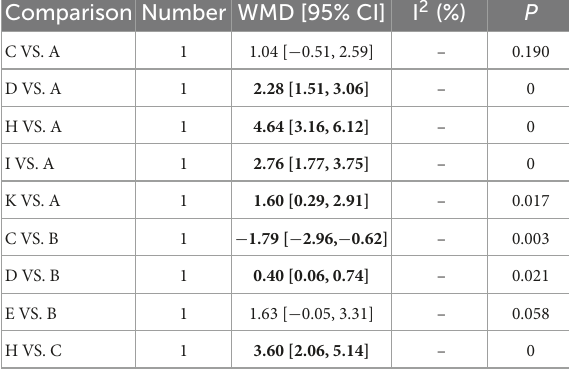
TABLE 4 Pittsburgh Sleep Quality Index (PSQI) pairwise meta-analysis results. Comparison Number WMD [95% CI]